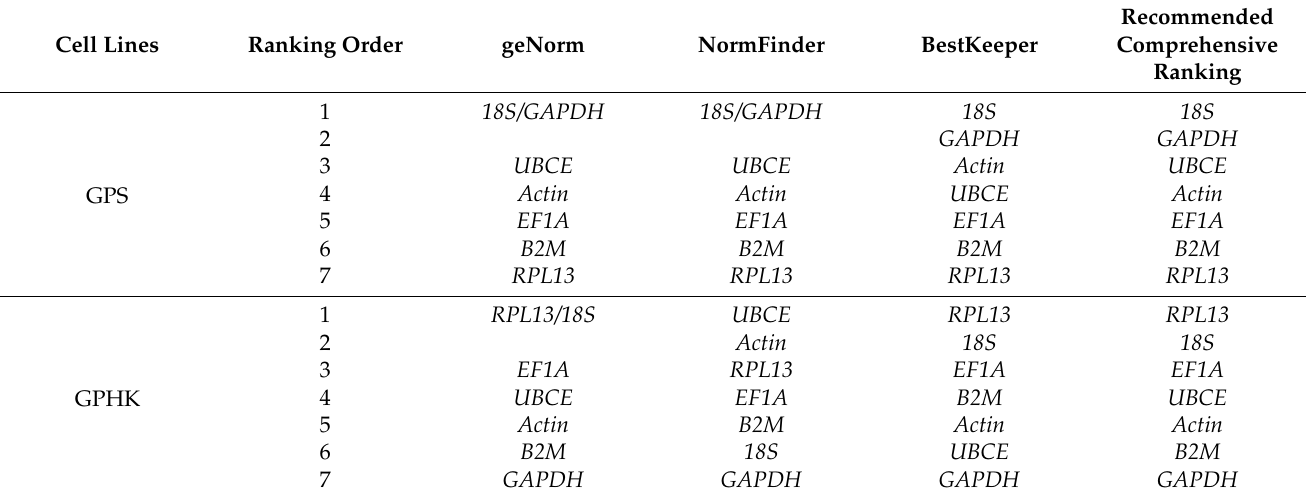
Table 6. The recommended comprehensive ranking of housekeeping genes based on three algorithm analyses in GPS and GPHK cells under normal